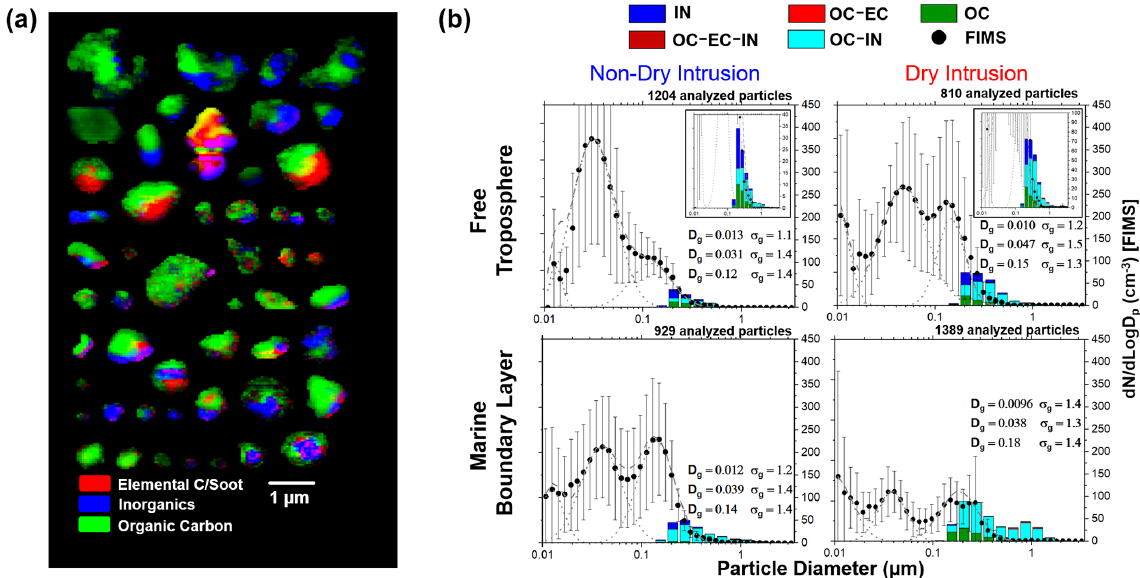
Figure 3. (a) Carbon speciation map of a subset of particles acquired by STXM from DI periods. Note that components can overlap, and each pixel can contain a different combination of the individual components: EC + IN constituents as purple; OC + EC as yellow; OC + IN as cyan. (b) Size distribution of analyzed particles identified via STXM/NEXAFS shown as an 8-bin per decade histogram to compare particle multi-component internal mixing state between atmospheric transport events. FIMS particle size distribution is overlaid to facilitate a visual comparison from the same atmospheric episodes. Abbreviations are as follows: IN – inorganics, OC – organic carbon (i.e., COOH), EC – elemental carbon (i.e., sp 2 C = C